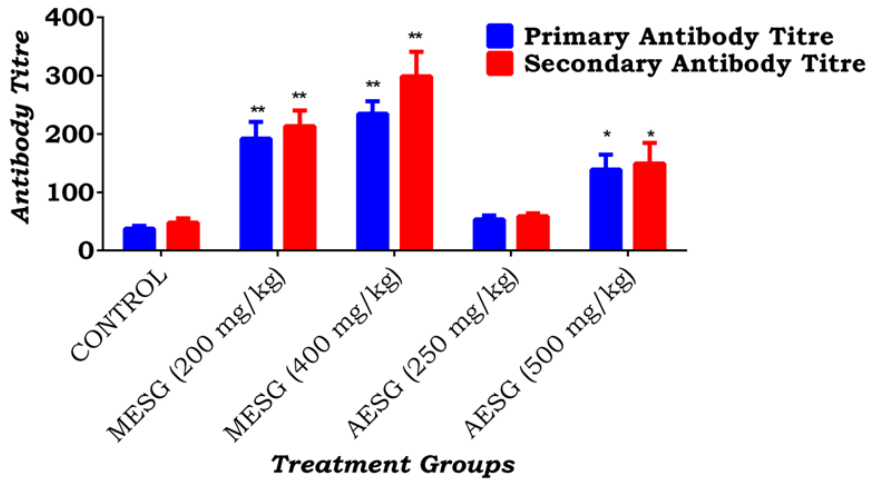
Figure. 1 Effect of Sesbania grandiflora on in- vivo SRBC specific humoral immune responses. Statistical analysis was carried out employing the ANOVA followed by Dunnett test *: <0.05, **: P<0.01 comparing with the control;